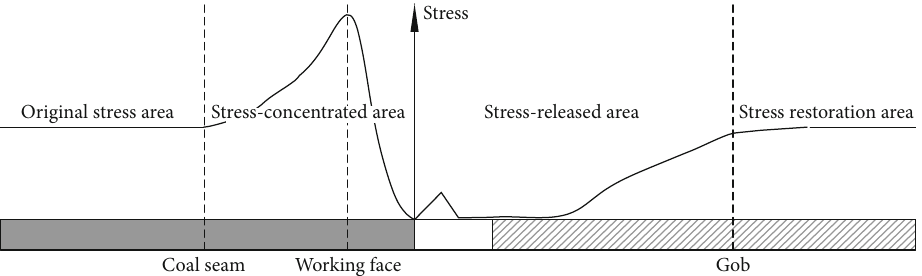
Figure 13: Distribution of support pressure around the working face.